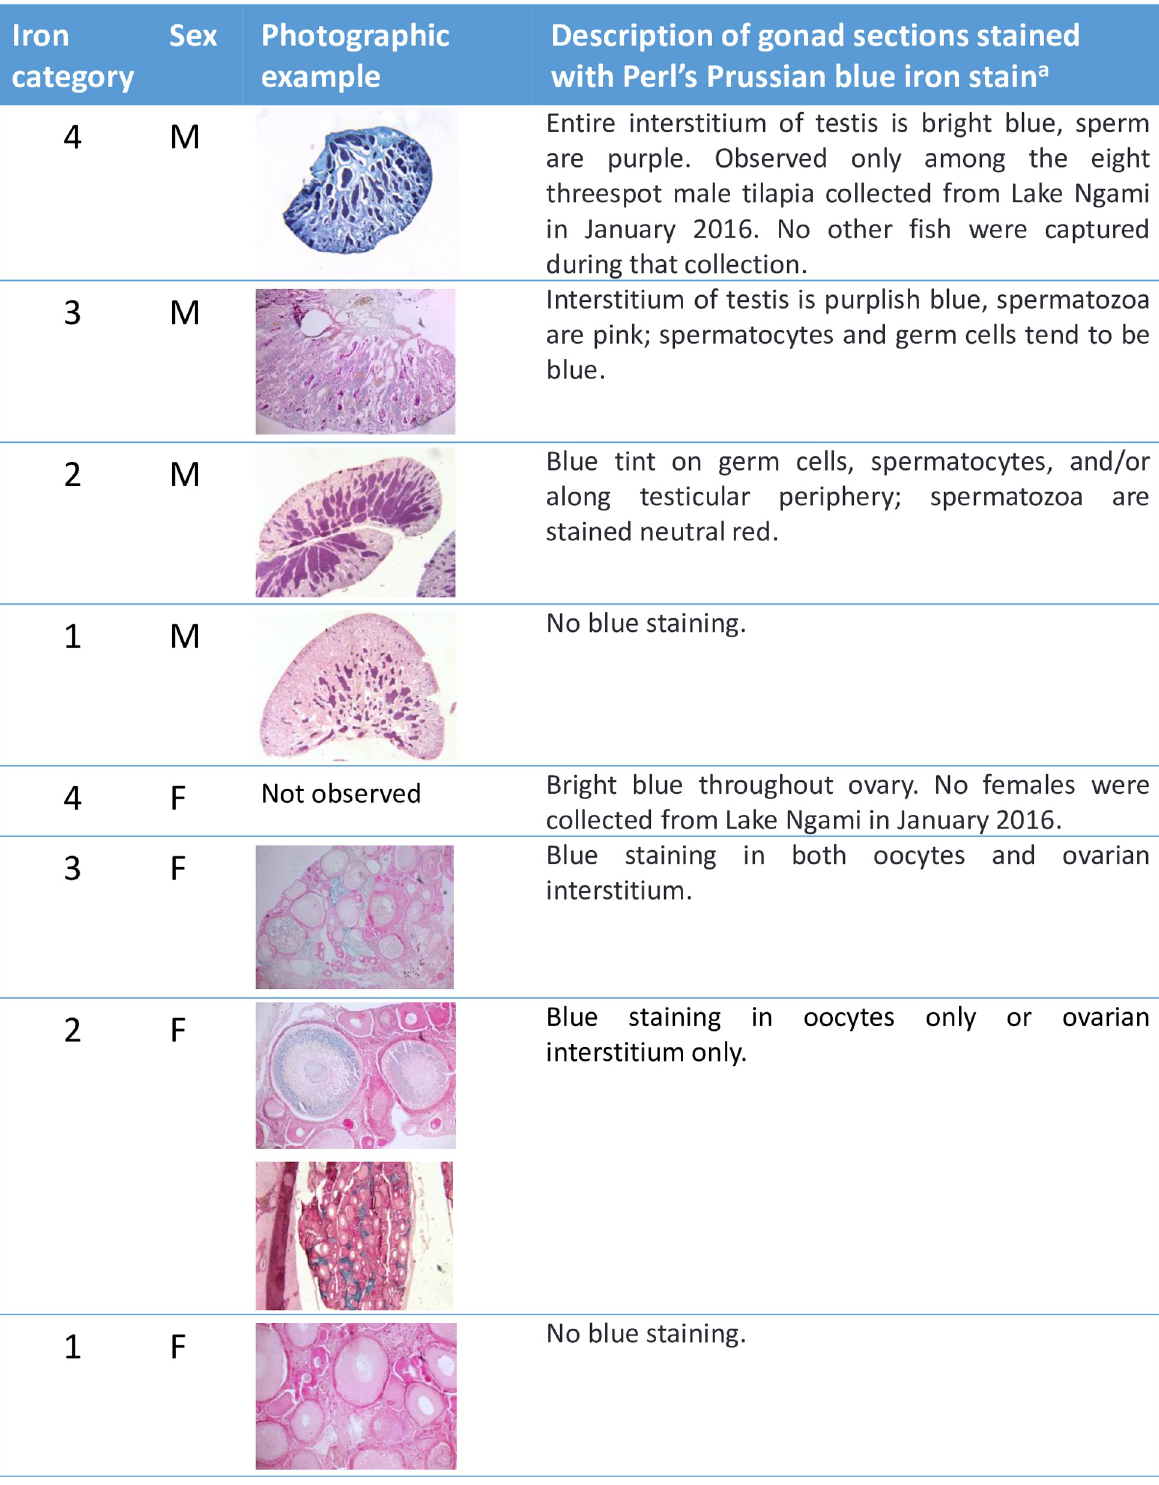
Fig 4. Iron category definitions for gonad sections stained with Perl’s Prussian blue iron stain. Categories 1–4 reflect the degree of iron staining in testis and ovary sections, with 4 representing the most iron. Category 4 was only observed in Lake Ngami fish, which were all male. Unlike liver and spleen, gonadal iron staining was infrequently observed and less abundant, with little evidence of concurrent inflammation. Additionally, among females, gonadal iron, if present at all, appeared to depend on oocyte developmental stage, with iron moving from the interstitium into